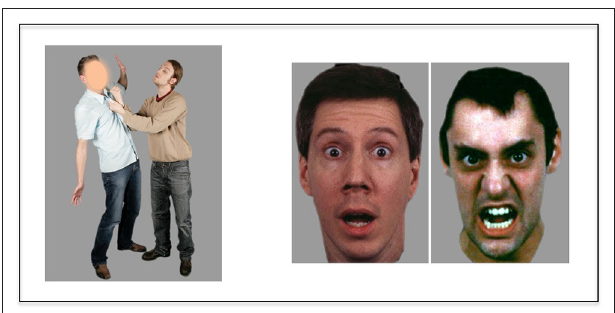
FIGURE 1 | Schema of emotion perspective-taking task. Participants are asked to choose which emotional expression (shown on the right) fits with the masked face (shown on the